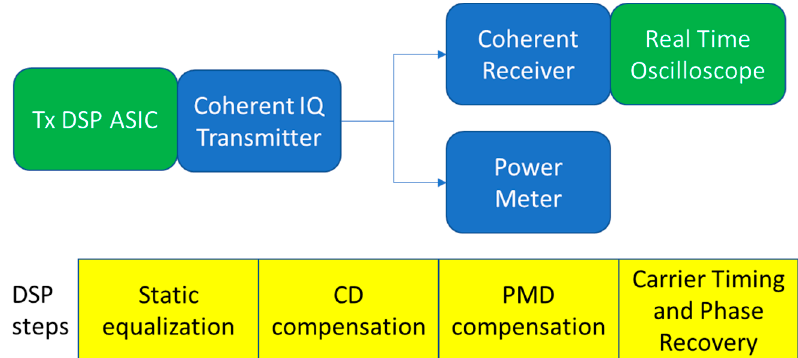
Figure 6. Experimental setup. A power meter is used to perform initial calibration with sinusoidal stimulus. Coherent receiver and real-time oscilloscope are used to recover the constellation diagram. The processing steps of DSP are also shown.